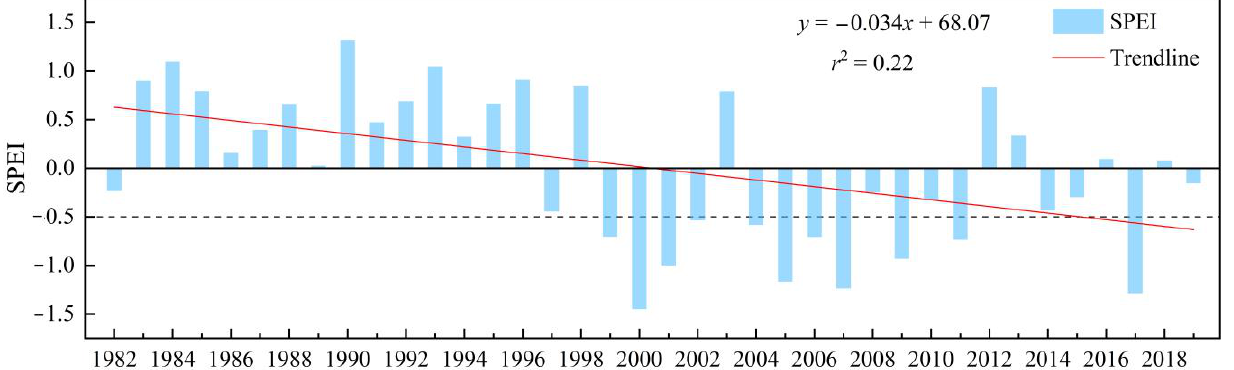
Figure 10. Change trend of SPEI over time. The blue bar chart is the long-term average value of SPEI in Inner Mongolia. The red line is the trendline. The slope of the trend line is − 0.034, p < 0.05. The black dotted line is the threshold for drought occurrence.